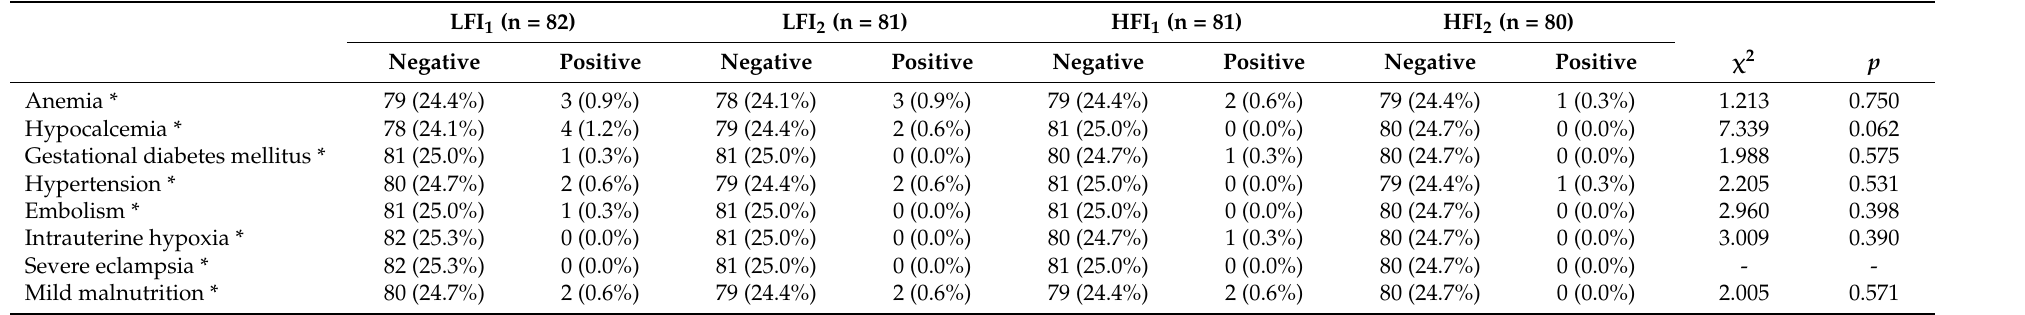
Table 6. Pregnancy complications and AFIs for participants with different TFI levels.